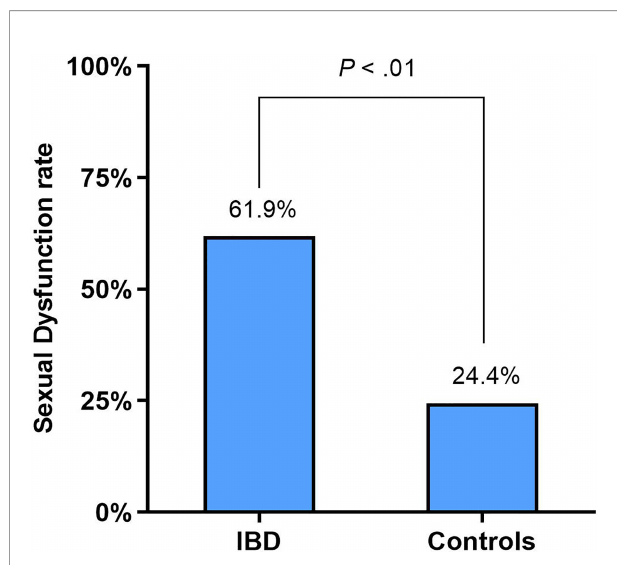
FIGURE 1 | Sexual function of IBD female patients compared with healthy controls according to